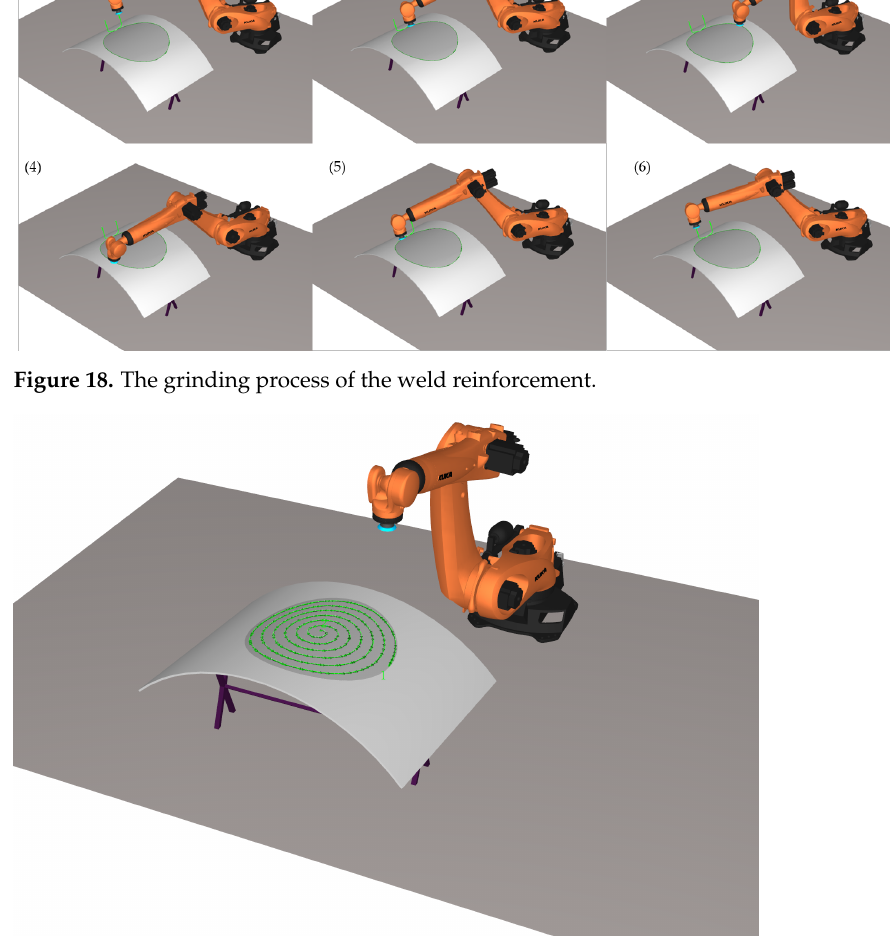
Figure 19. The spiral grinding trajectory of the defect